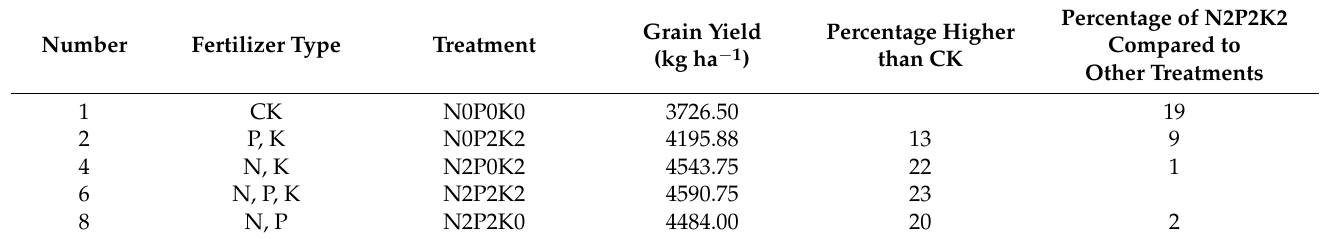
Table 3. Fertilizer interaction effect and abundance or shortage status of nutrients.